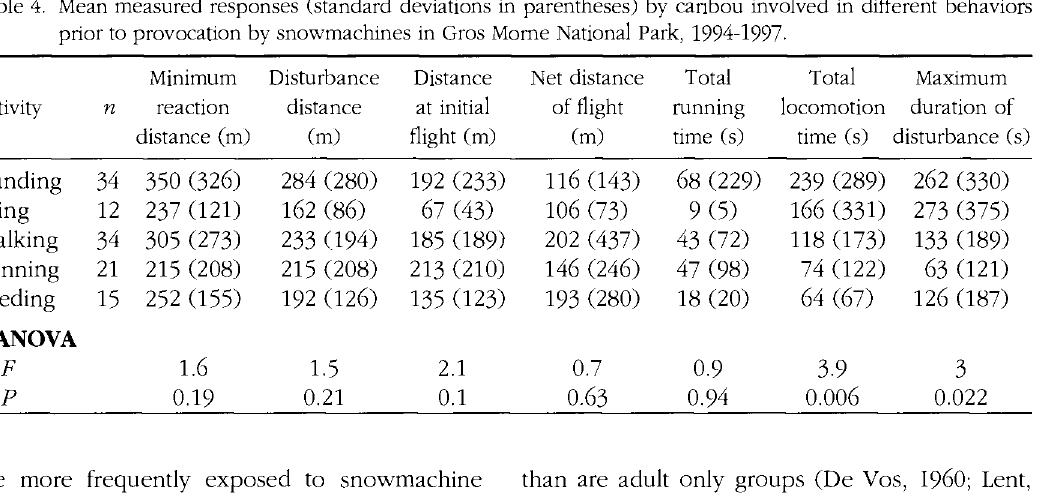
Table 4. Mean measured responses (standard deviations in parentheses) by caribou involved in different behaviors prior to provocation by snowmachines in Gros Morne National Park,